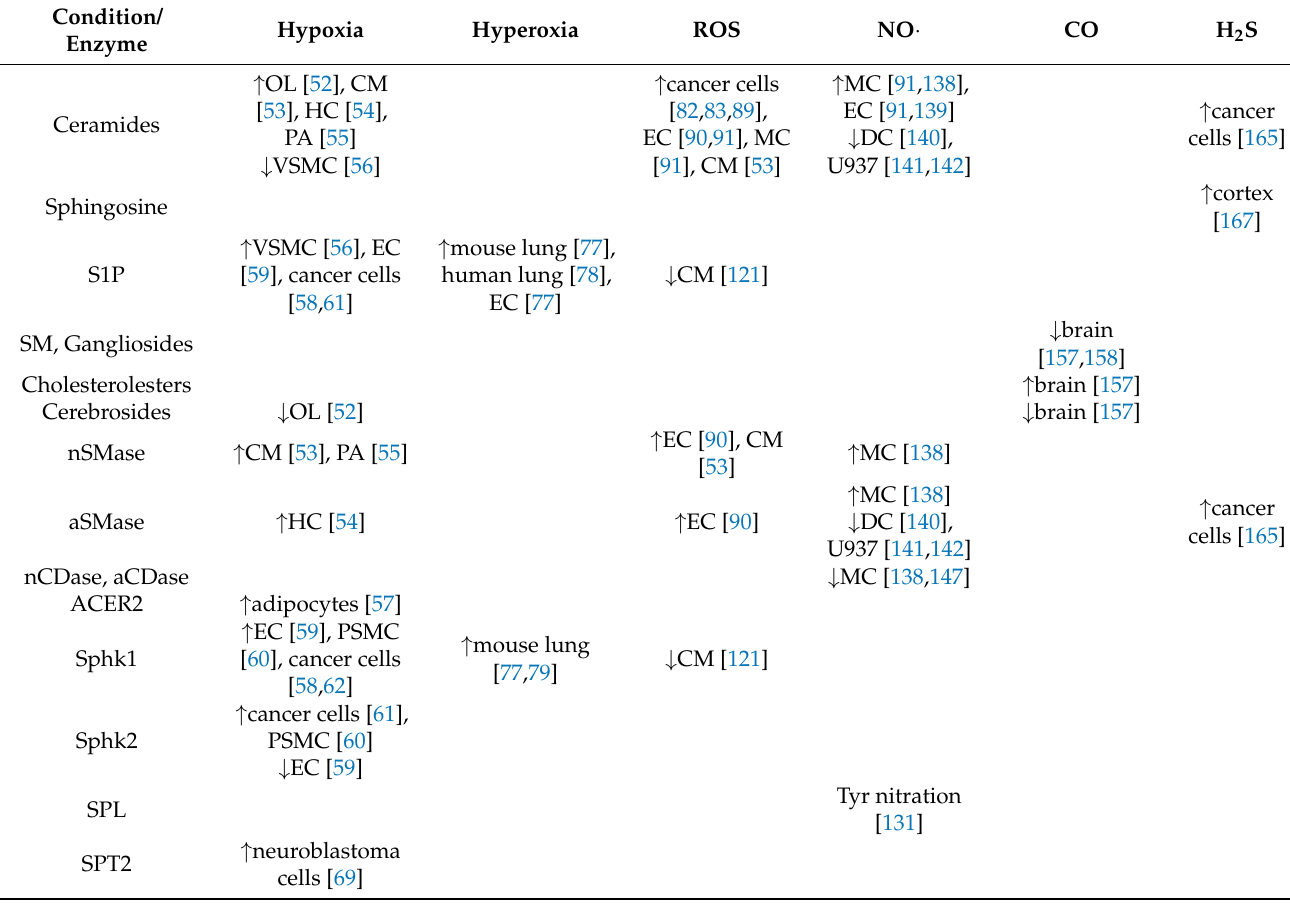
Table 1. Regulation of sphingolipids and their key enzymes by redox-active